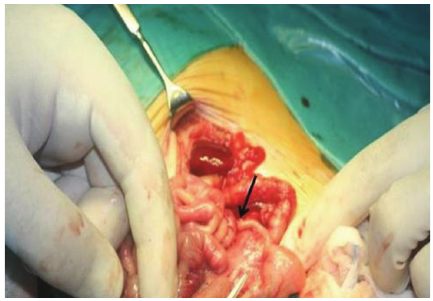
Figure 1: Appendix with perforation near the tip.